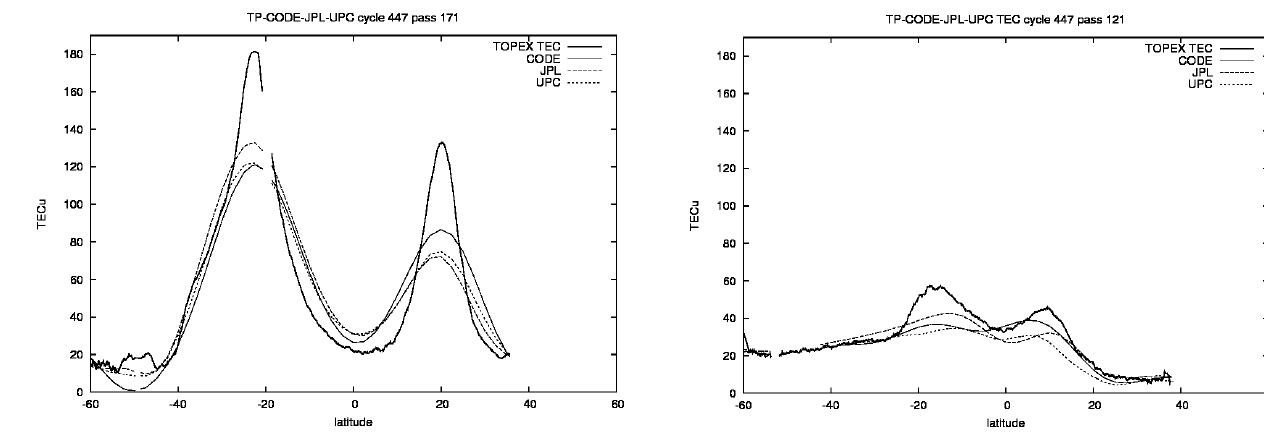
Fig. 4c. Comparison among GIM’s TEC models and TOPEX TEC during a pass on 7 July 2000 of quiet pre-storm days as a function of geographic latitude.